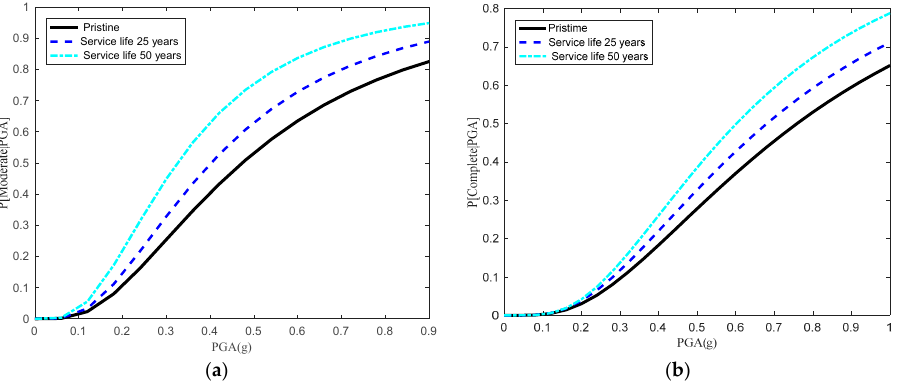
Figure 16. Time-dependent system seismic fragility curves for an MSC concrete girder bridge for ( a ) a moderate damage state and ( b ) a complete damage state subjected to prestress losses and cracking.